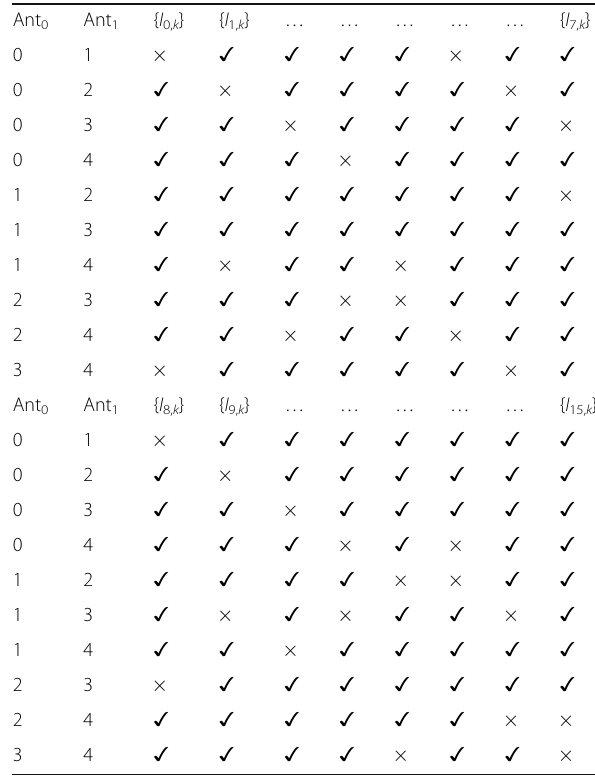
Table 2 TAC-sets for GSM with N t = 5, N a =